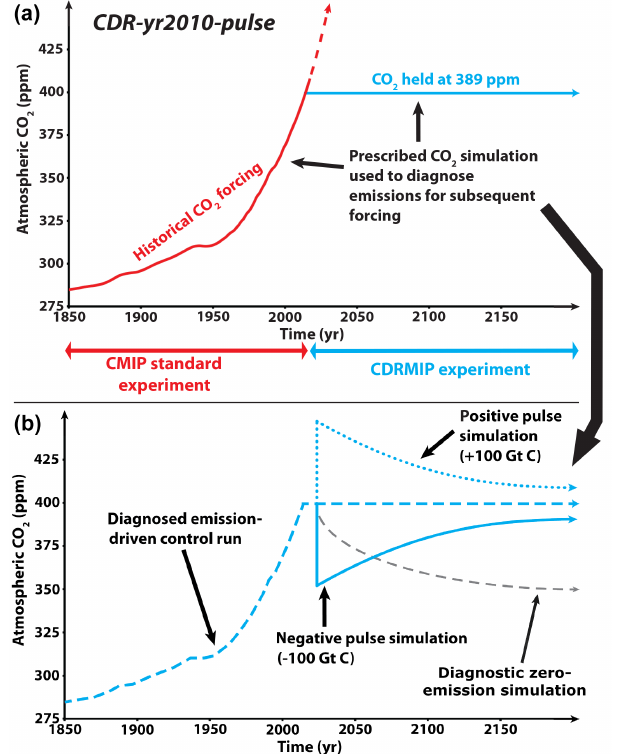
Figure 5. Schematic of the CDRMIP instantaneous CO 2 removal and addition from a perturbed climate experimental protocol ( CDR- yr2010-pulse ). (a) Initially historical CO2 forcing is prescribed and then held constant at 389ppm ( ∼ year 2010) while CO 2 emissions are diagnosed. (b) A control simulation is conducted using the diag- nosed emissions. The negative–positive pulse experiments are con- ducted by instantly removing or adding 100GtC to the atmosphere of the CO 2 -emission-driven simulation 5 years after CO 2 reaches 389ppm. Another control simulation is also conduced that sets emissions to zero at the time of the negative pulse. The emission- driven simulations continue for as long as computationally